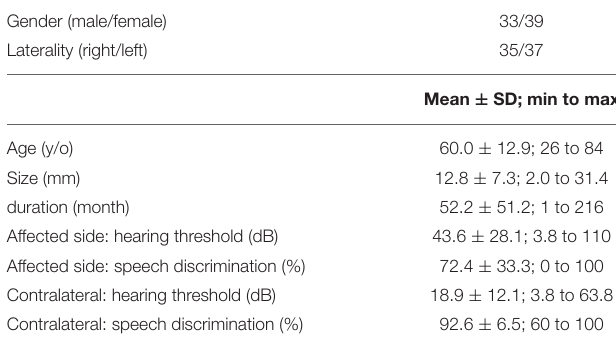
TABLE 1 | Overall patient characteristics in this study.